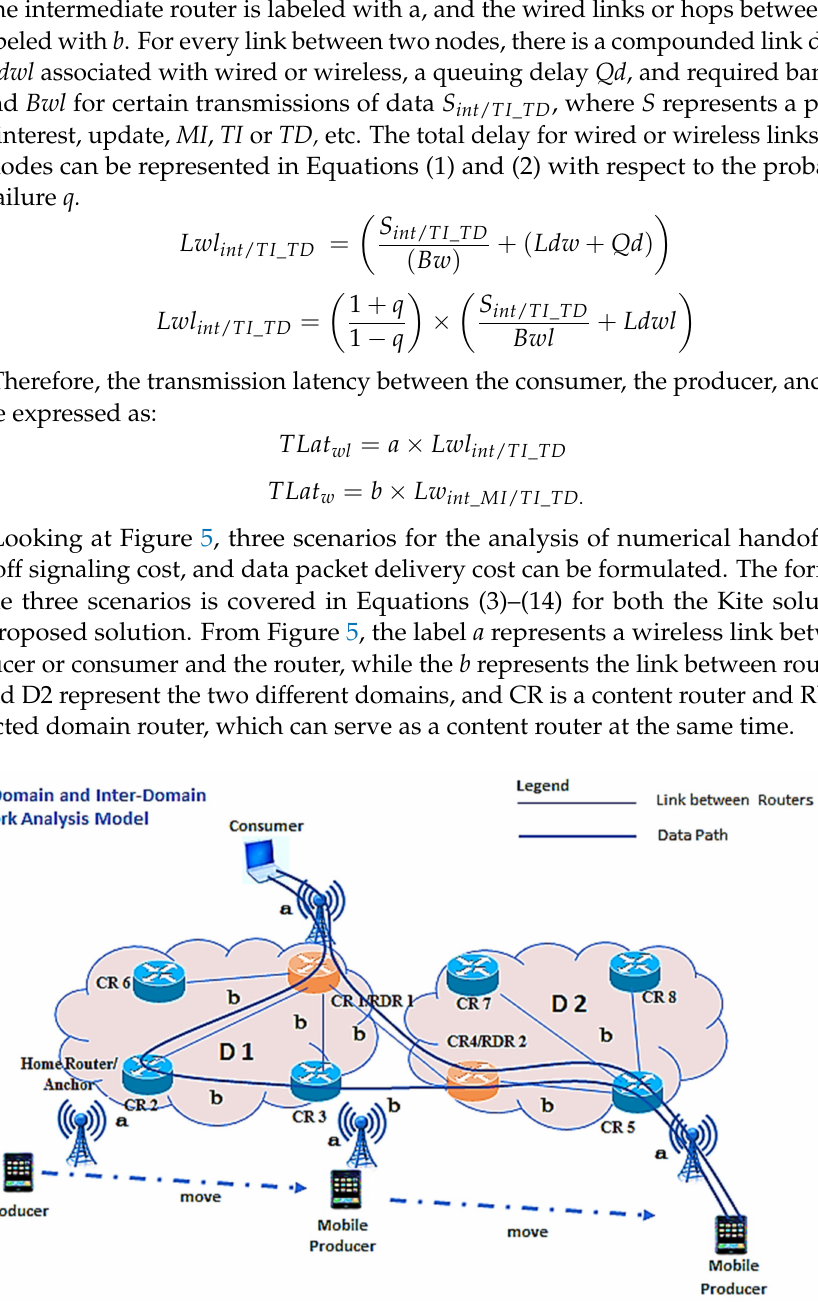
Figure 5. Network analysis